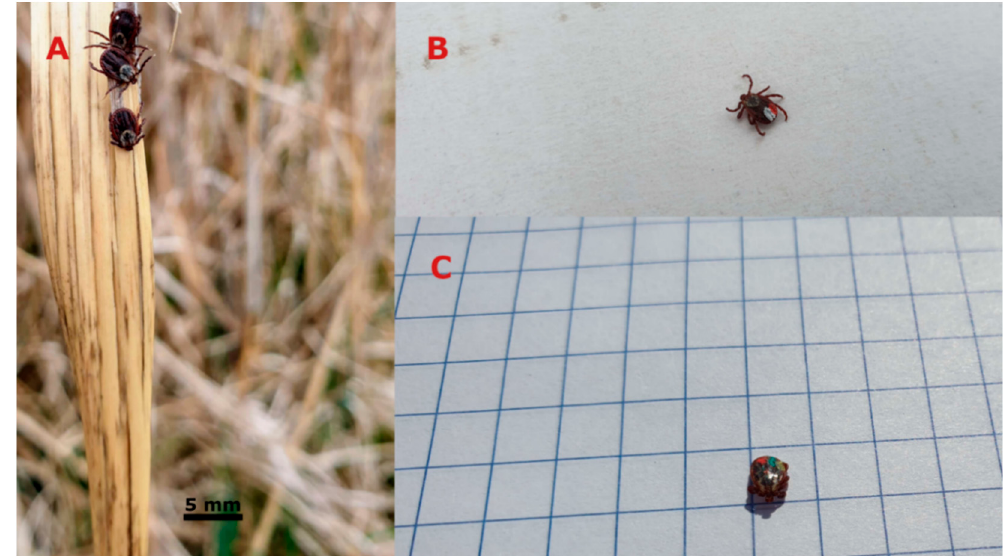
Figure 2. Marked Dermacentor reticulatus adult ticks repeating their activity. ( A ) host seeking D. reticulatus females; specimen at the top marked with white colour repeating host ‐ seeking activity, ( B ) D. reticulatus female active for the third time, ( C ) D. reticulatus male active for the fourth time.